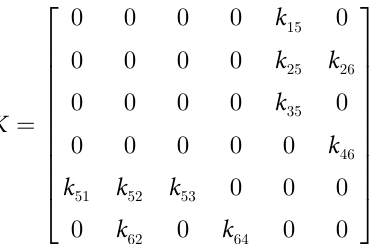
S1 Table. Rate parameter descriptions, values used and ranges for the model versions allow- ing for animal